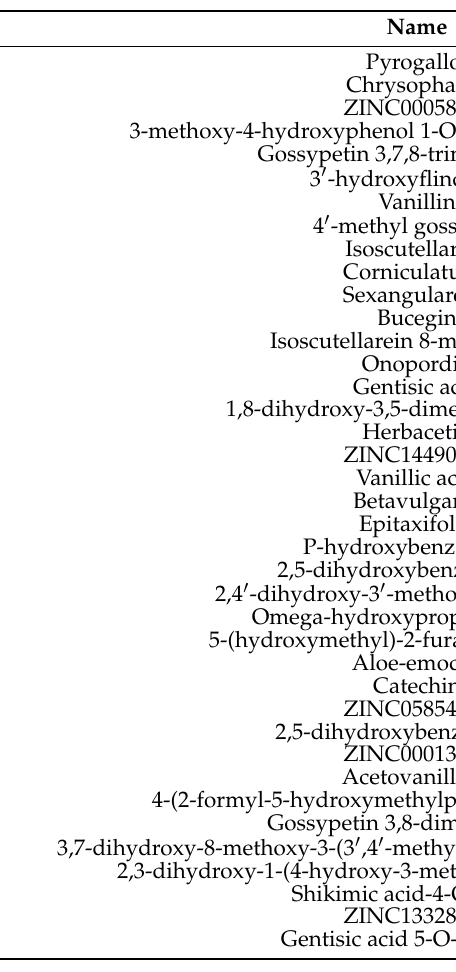
Table 2. Hit molecules arranged in order of decreasing pharmacophore fit score. The compounds were used for further downstream analysis including molecular docking.